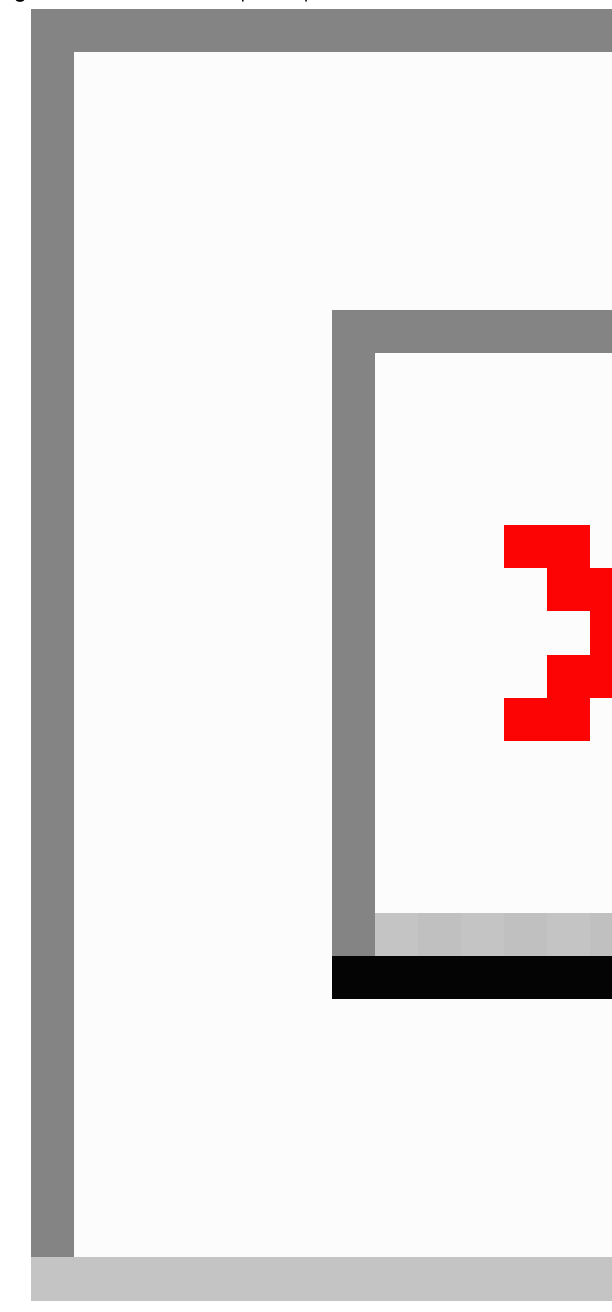
Figure 1. Screenshot of the patient